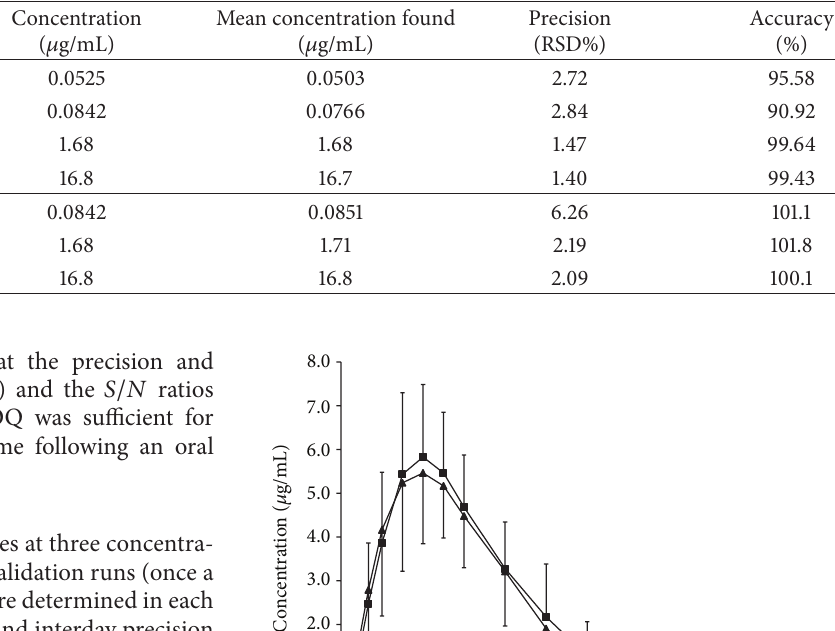
Table 1: Intraday and interday precision and accuracy of cefuroxime in human plasma.